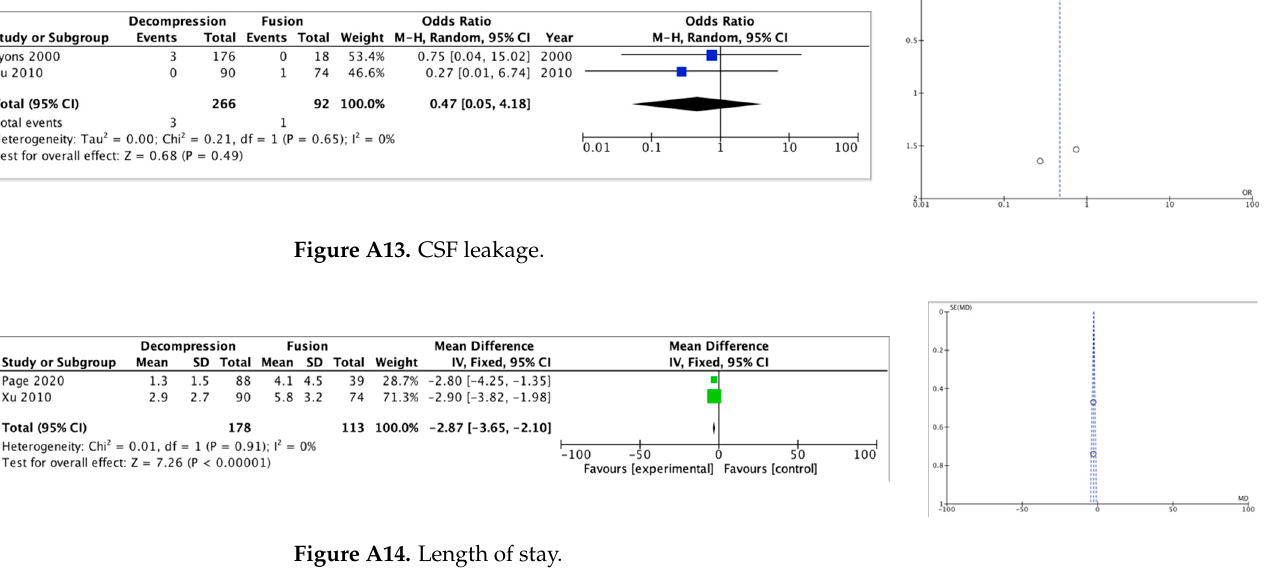
Figure A12. Infection.